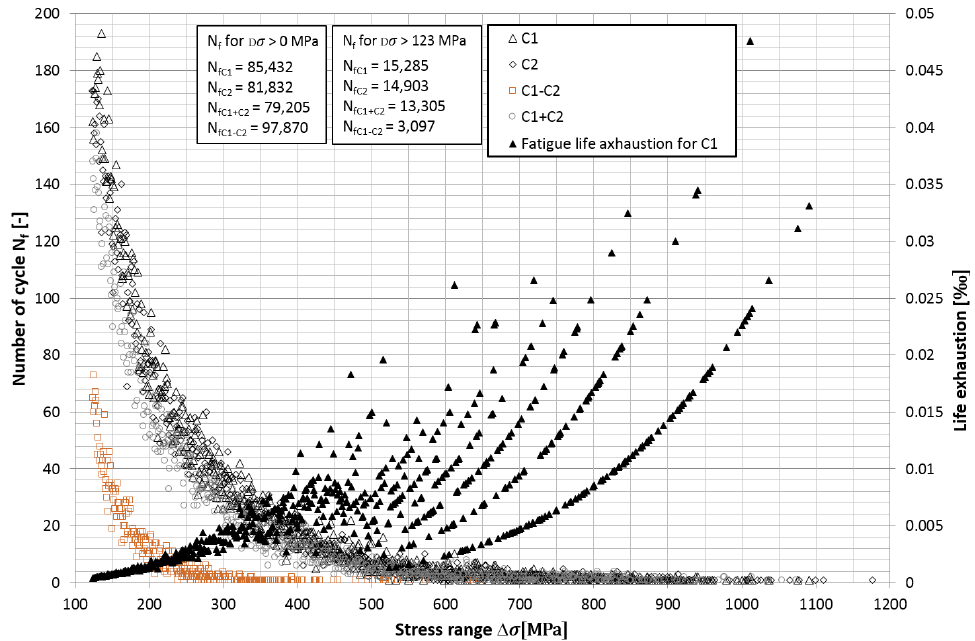
Figure 13. Number of cycles and fatigue life exhaustion of leaf springs of axis I.